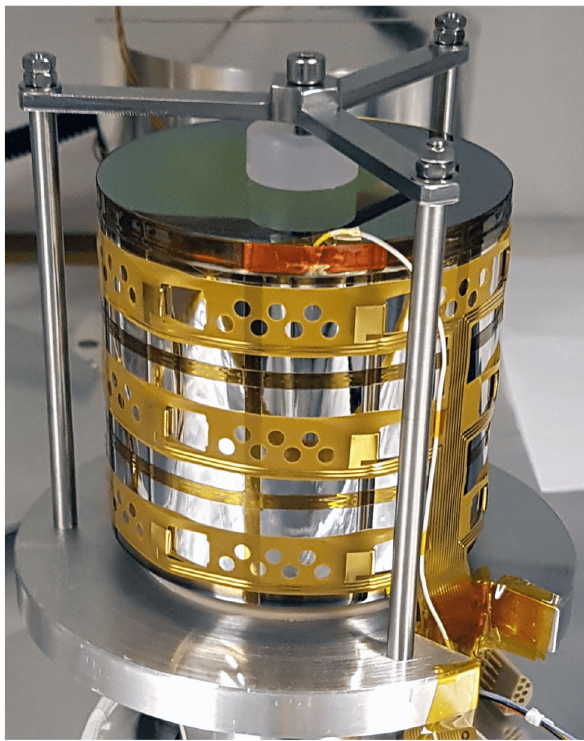
Fig. 4 Picture of the germanium detector Super-Siegfried taken after all segments were fully metalised. The Kapton printed-circuit-board and the holding structure are also visible